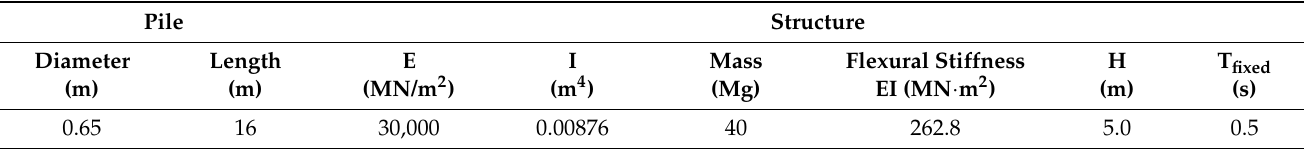
Table 4. Pile and superstructure properties used in the numerical analyses.